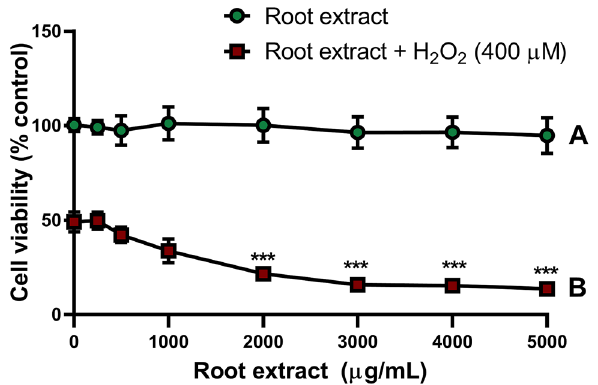
Figure 1. Effects of crude D. viscosa root extract on PC12 cell viability. Mean cell viability (± SD) measured by XTT assay for ( A ) PC12 cells incubated with concentrations of crude D. viscosa root extract (0–5000 μg/mL) for 14 h or ( B ) PC12 cells pretreated with concentrations of crude D. viscosa root extract (0–5000 μg/mL) for 2 h followed by incubation for 12 h with H 2 O 2 (400 μM). Two-way ANOVA: crude root extract concentration, p < 0.0001; pretreatment, p < 0.0001; interaction, p < 0.0001. Dunnett’s test: ***, p <